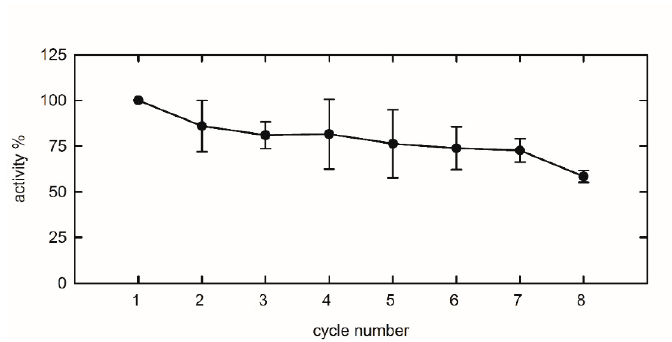
Figure 6. Repeated uses of immobilized puuE. Reactions were carried out at 37 °C in 20 mM potassium phosphate, pH 7.4, in the presence of 0.2 mM racemic allantoin, and stopped after a fixed time of 10 min. Reported percentage values refer to (S)-allantoin consumption as monitored at 210 nm through CD spectra. The mean value of three reactions at cycle 1 represents the reference for the normalization of subsequent cycles. Data are represented as mean ± s.d. and lines are for eye-guidance only.